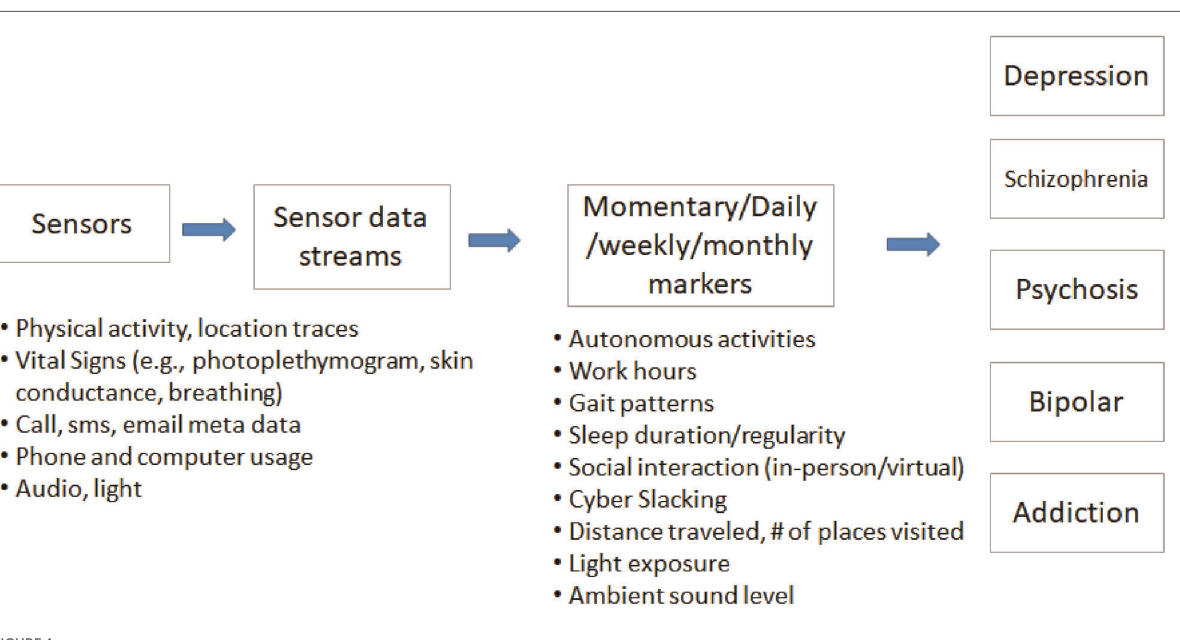
FIGURE 1 Example of a layered, hierarchical sensor-based